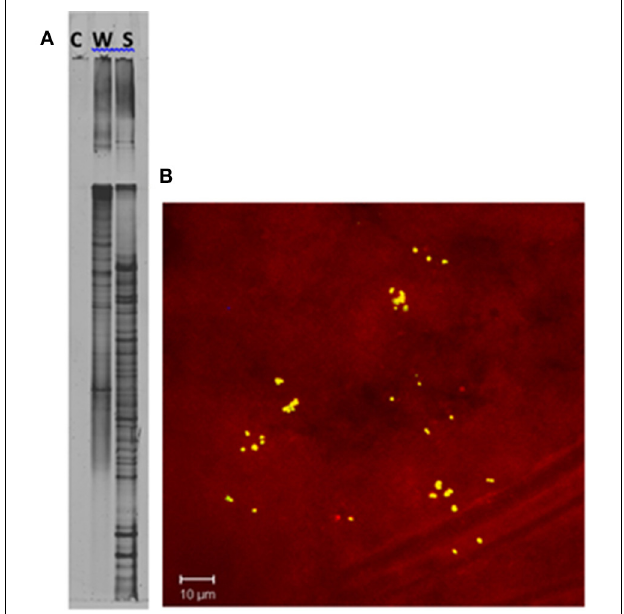
FIGURE 3 | Confirmation of unique bacterial presence in the sponge tissue. (A) DGGE analysis of a PCR negative control (C), seawater (W), and Acanthostrongylophora sp. (S). The increase in bands in the sponge sample indicates a higher diversity in the sponge than in the surrounding water column. (B) Epifluorescence micrograph section of Acanthostrongylophora sp. mesohyl tissue visualized by FISH. The mesohyl region was hybridized